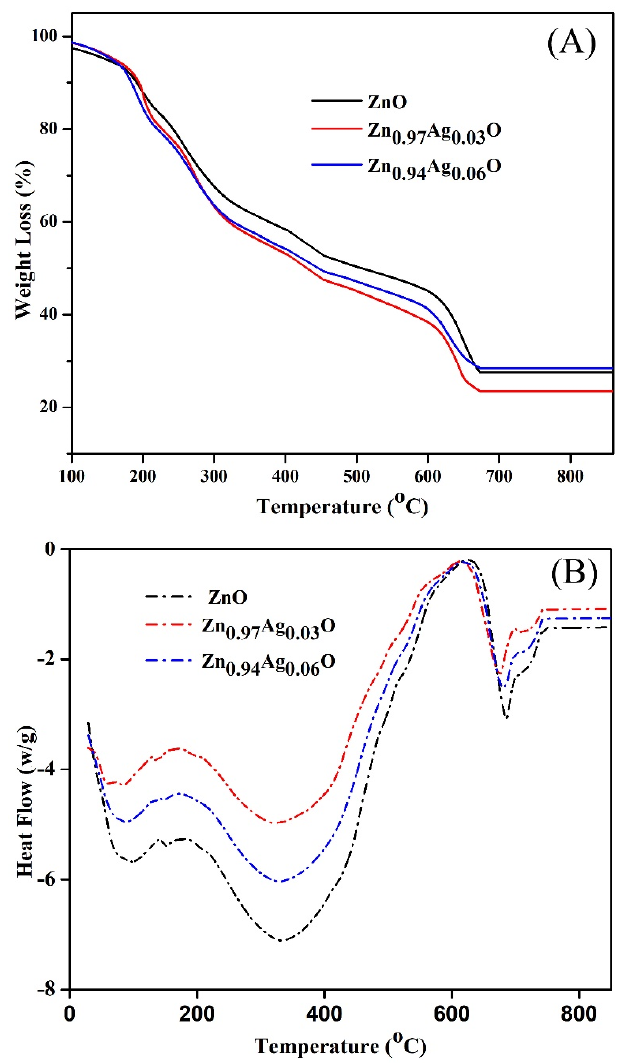
Figure 9. ( A )Thermal analysis result of the synthesized Ag-ZnO NPs and ( B ) the differential scanning calorimetry (DSC) curve of the Ag-ZnO NPs.